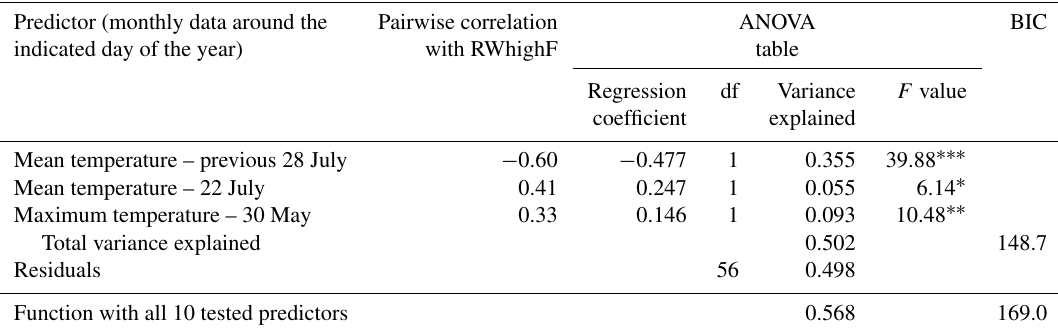
Table 3. ANOVA table for the best response function (here, a combination of 3 of the 10 tested predictors minimized the BIC) with the observed mean detrended ring width series (RWhighF) as the dependent